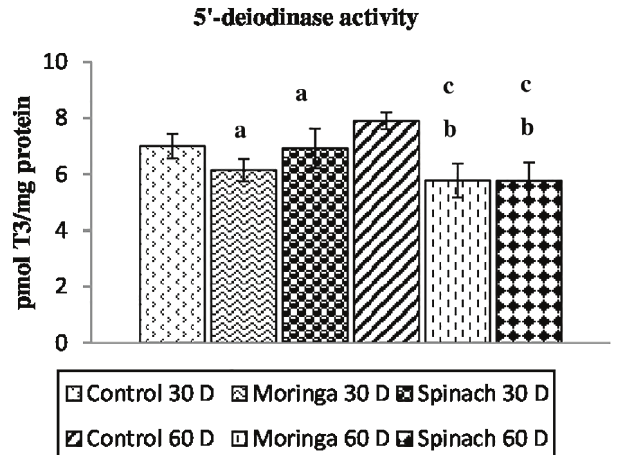
FIGURE 4 - Thyroidal 5’-delodinase I(DI) activity of selected plant foods treated animals for 30 days and 60 days respectively. Each pool contained a mixture of three thyroid glands isolated from three individual rats. One-way analysis of variance (ANOVA) test followed by Tukey’s post hoc test was done to determine differences across means of different groups. Mean values are significantly different by ANOVA at p<0.05. a Control 30 days versus treated 30 days group; b Control 60 days versus treated 60 days group; c Treated 30 days versus treated 60 days